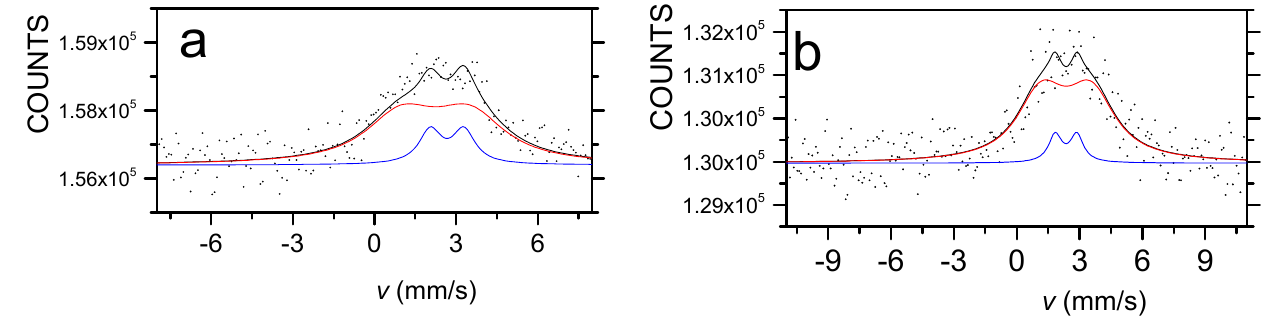
Figure 7. 119 Sn conversion electron Mössbauer spectra of DC3 ( a ) and PP3 ( b ) electrodeposited qua- ternary Sn-Fe-Ni-Co alloy coatings. The red and blue components show the ferromagnetic and par- amagnetic amorphous phases, respectively, while the black line indicates their spectral superposi- tion.